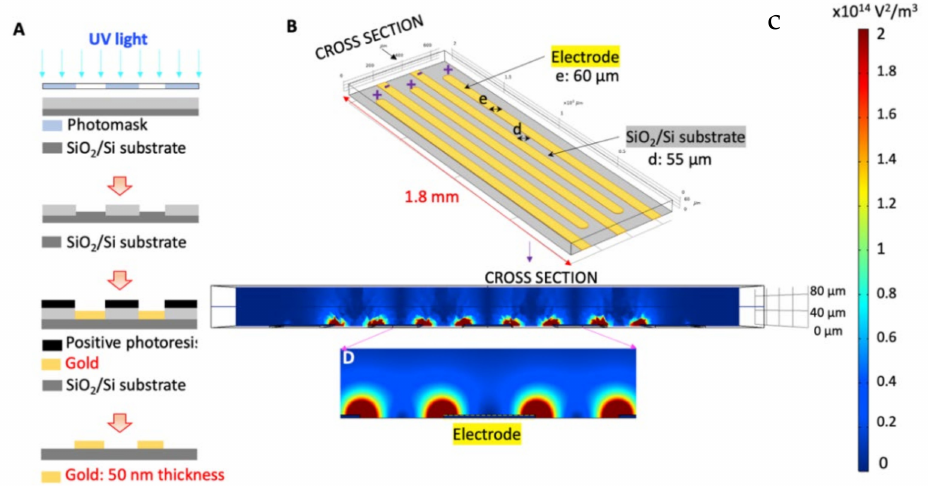
Figure 1. DEP chip ( A ) Fabrication process of the gold electrode array, ( B ) Organization of the 65 pairs of electrodes in the microfluidic chip, ( C ) Distribution of the electric field gradient (V 2 /m 3 ) at the cross-section view of the device using COMSOL Multiphysics simulation